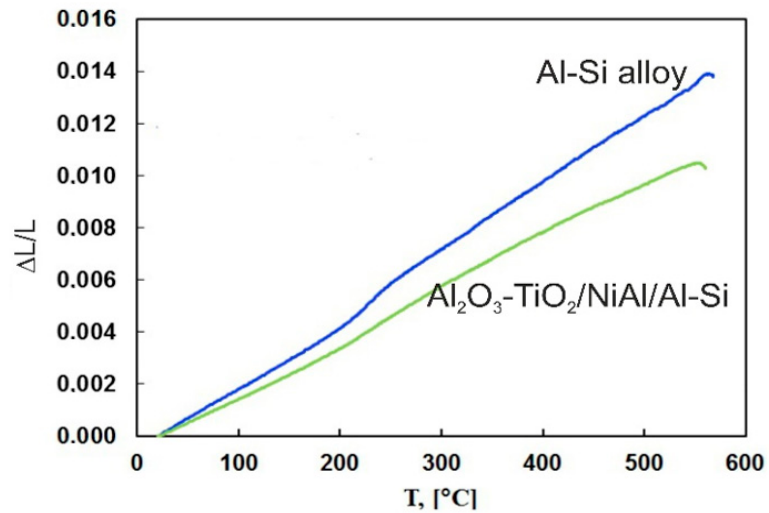
Figure 7. Comparison of changes in linear expansion for the Al-Si alloy and the Al 2 O 3 -15 wt.%TiO 2 /NiAl/Al-Si coating system plotted in function of